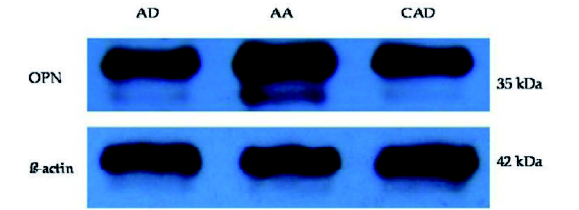
Fig. 3 - Western blot assay of the expressions of osteopontin protein.